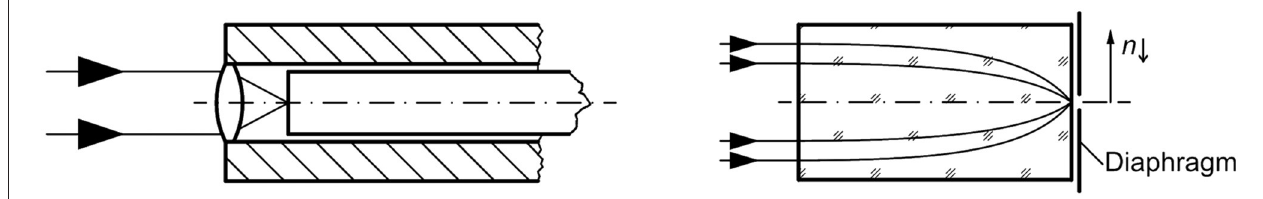
FIGURE 12 | Left: A possible improvement to narrow the angle α involves using a lens before light enters the fiber, similar to the situation in compound eyes (cf. Figure 3 left). Right: Another possible strategy to narrow angle α is using a lens cylinder (Exner, 1891) [also termed: gradient index rod lens; Hecht (2017, p. 284); Edmund Optics, Available at: https://www.edmundoptics.com/optics/optical-lenses/aspheric-lenses/Gradient-Index-GRIN-Rod-Lenses/ (accessed February 16, 2018)] before light enters the fibers (on the right side behind the diaphragm; not shown). The refractive index n in such a cylinder gradually decreases with distance from the axis. This lets the light beams in the cylinder converge. With proper cylinder length, this can be advantageous. In a longer lens cylinder, light periodically converges, and diverges. A diaphragm before the fiber can help to additionally narrow angle α .